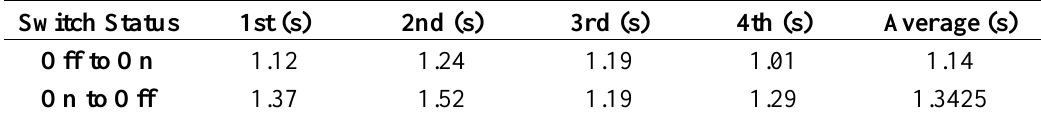
Table 2. Response time with changing frequency in a reconfigurable